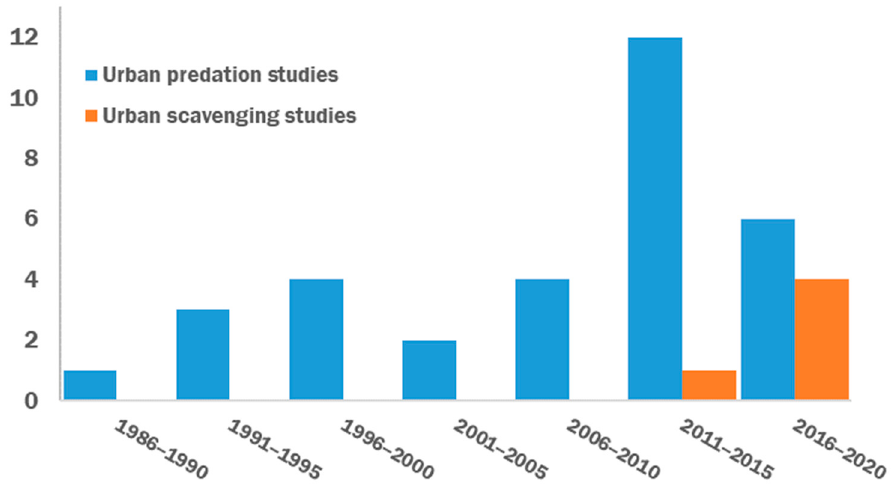
Figure 1. Temporal comparison between urban predation and urban scavenging published studies, based on the total of articles retained strictly from the systematic review, conducted with closed search.